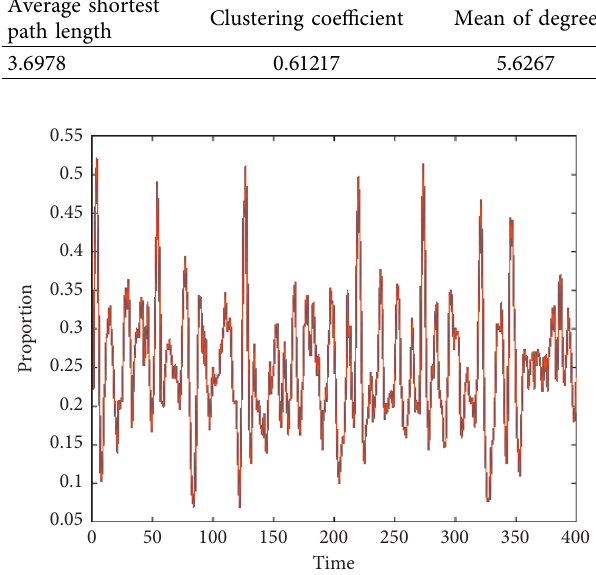
Figure 6: Infected individual proportion.